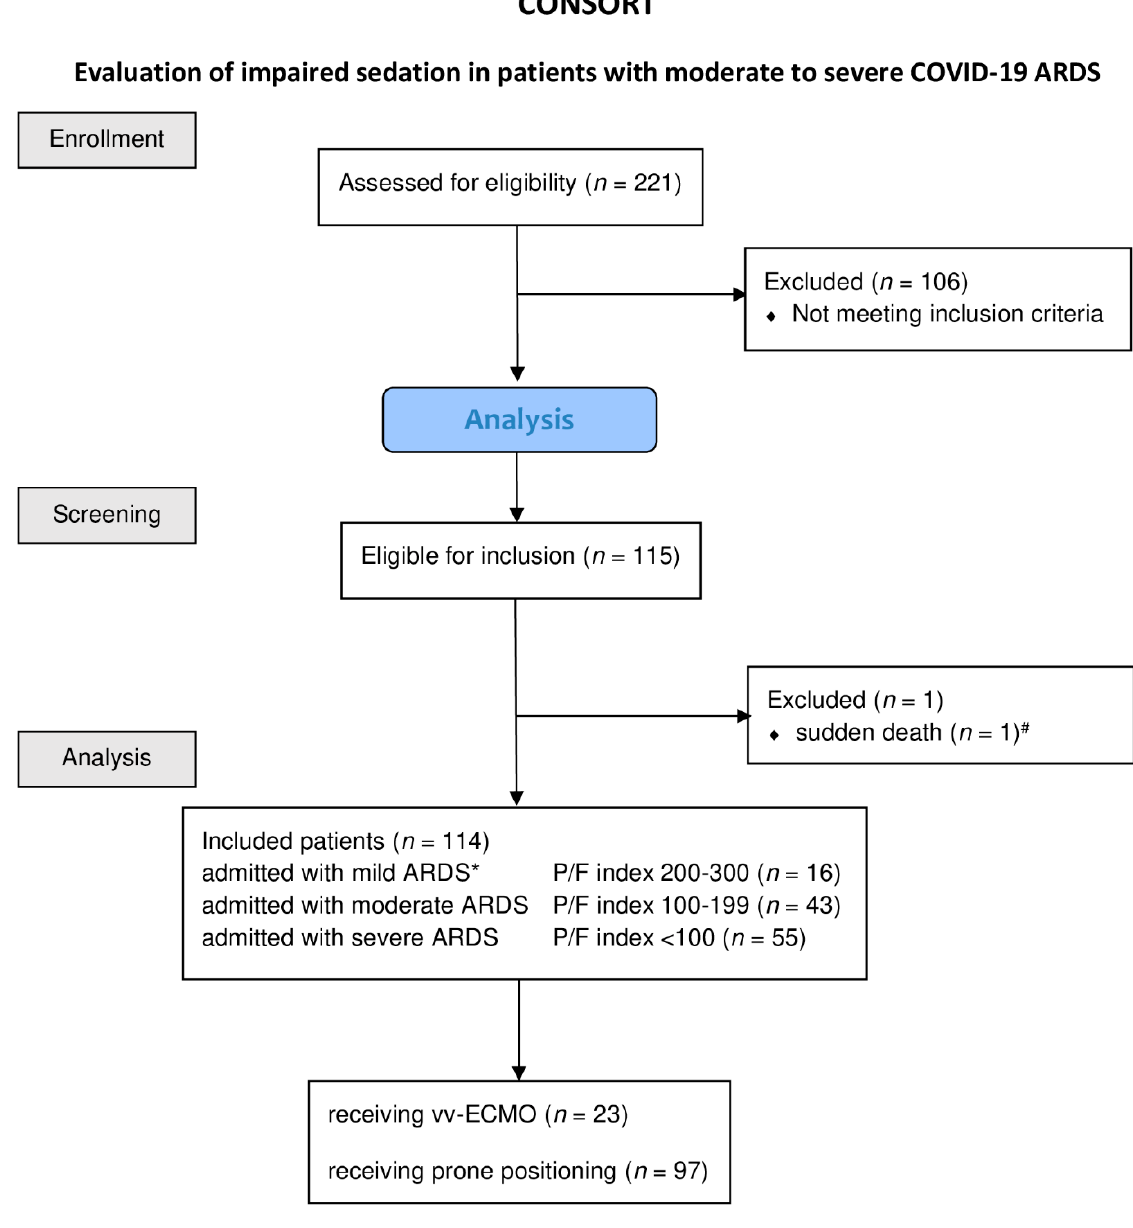
Figure 1. Consolidated Standards of Reporting Trials (CONSORT) diagram of patients included into the study. Diagram of the inclusion process, as well as the reasons for exclusion and treatment, patients receiving vv-ECMO or prone positioning. Abbreviations: ARDS, acute respiratory distress syndrome; paO 2 , oxygen partial pressure in arterial blood; FiO 2 , inspiratory oxygen fraction; P/F index, paO 2 ·FiO 2 − 1 ; vv-ECMO, veno-venous-extra corporeal membrane oxygenation. * ARDS severity classification according BERLIN definition Yes in all cases it is a minus value of the RAAS. # Patient died within less than eight hours from admission.